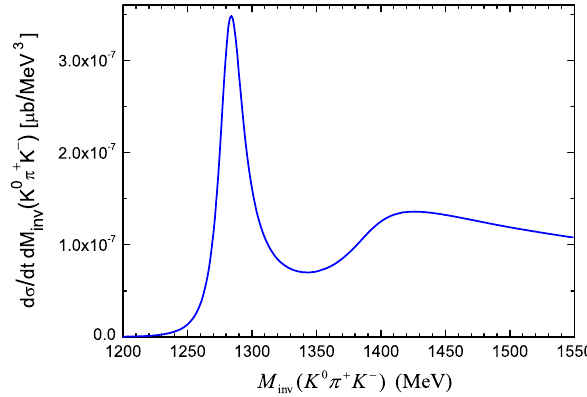
√ s = 3010 MeV, with t fixed